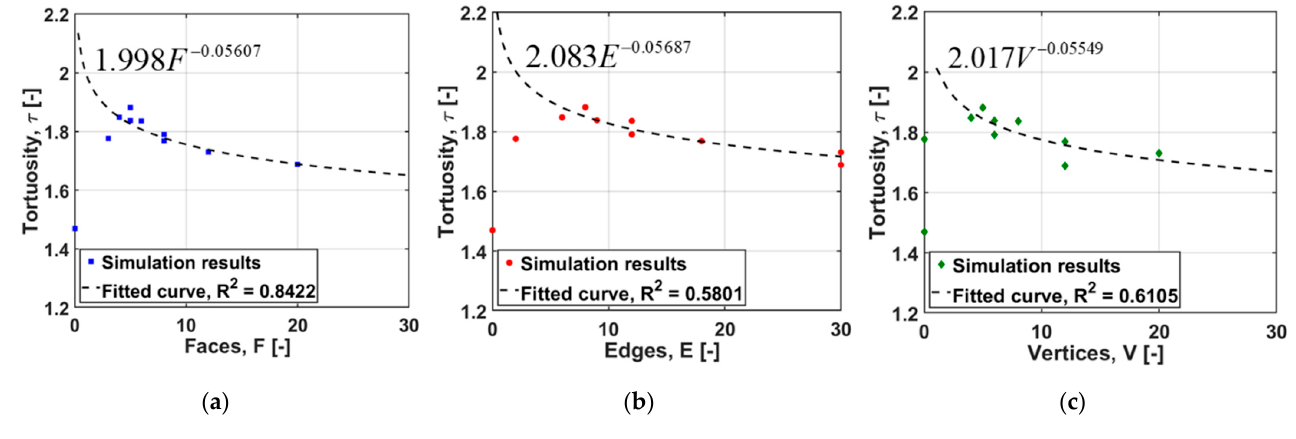
Figure 9. Effect of particle shape parameters on tortuosity with fitted curves: ( a ) number of faces; ( b ) number of edges; and ( c ) number of vertices.